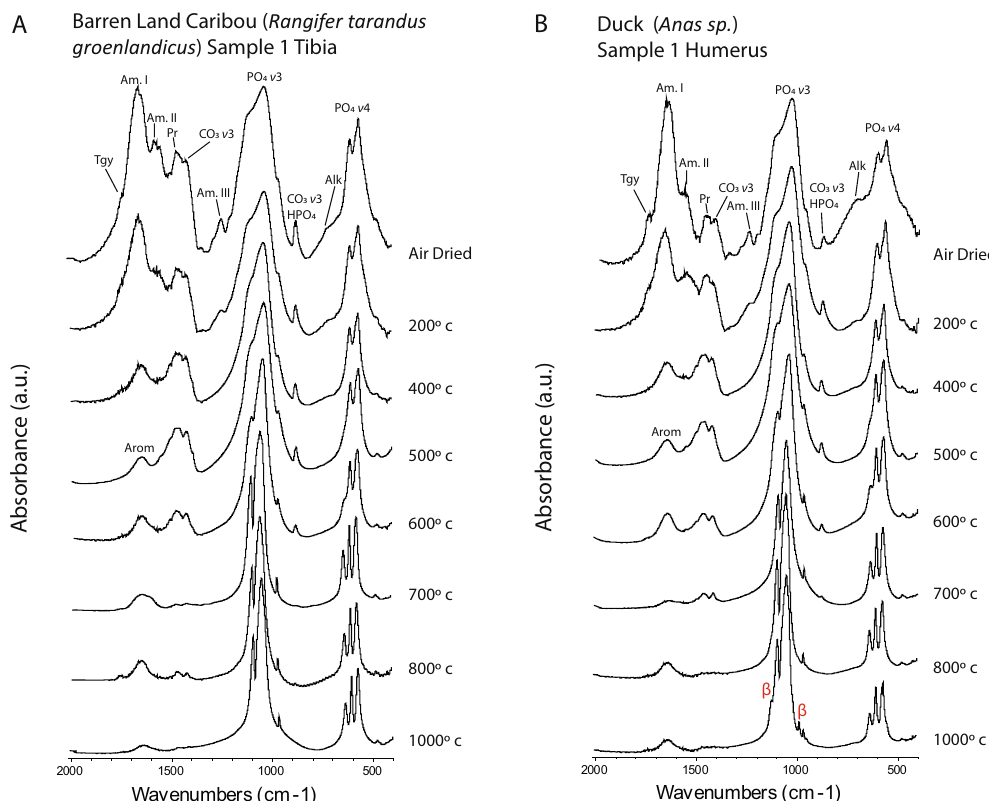
Figure 4. FTIR Spectra of Caribou and Duck Bones Heat Treated through a Ramping Temperature Sequence between 200 °C and 1,000 °C. ( A ) Caribou; β MgTCP does not form; ( B ) Duck; β MgTCP is only formed at high temperatures; abbreviations: Tgy = triglyceride ester; Am = amide; Alk = alkene; Pr = proline; CO 3 = carbonate; PO 4 = phosphate; HPO 4 = hydrogen phosphate; Arom = aromatic char compounds; WH = whitlockite; β = beta magnesium tricalcium